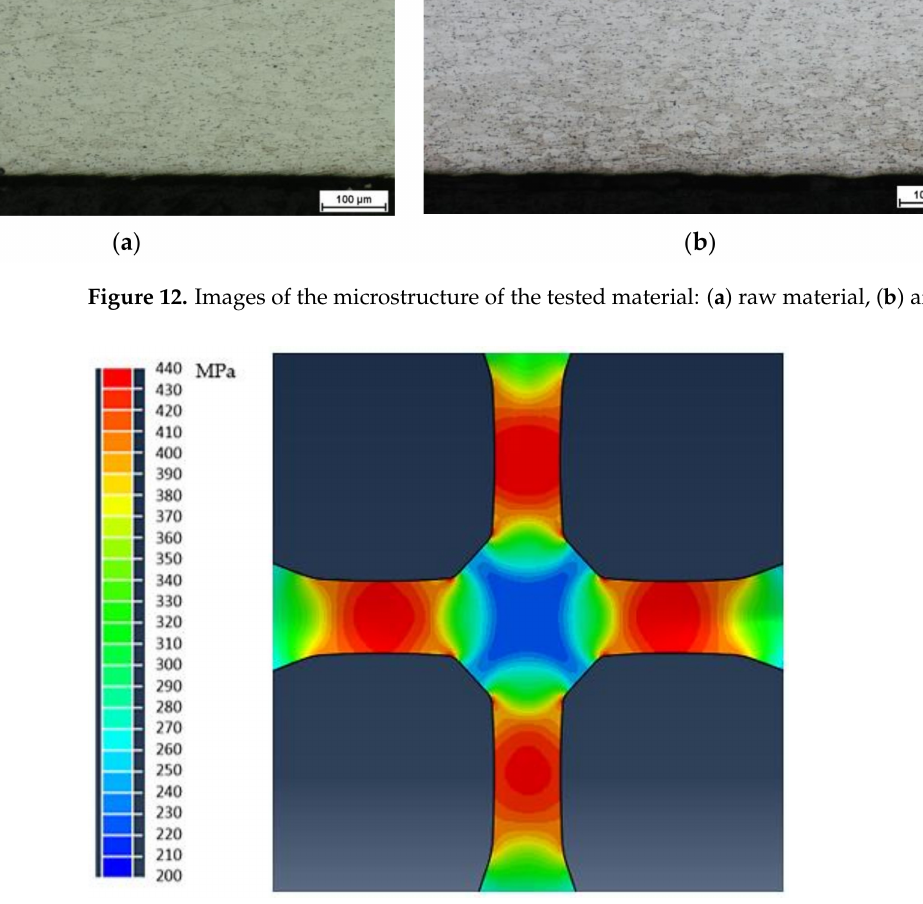
Figure 13. Von Misses stress distribution for